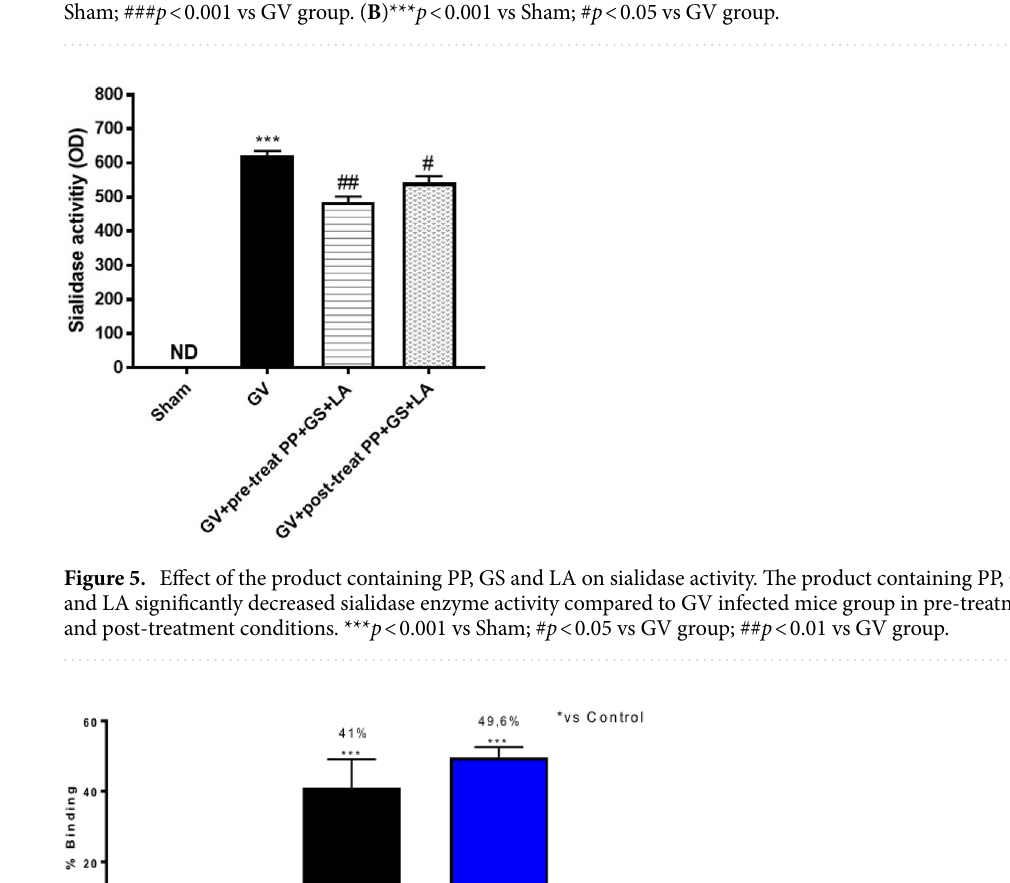
Figure 4. Effect of the product containing PP, GS and LA on MPO activity. The product containing PP, GS and LA significantly decreased MPO activity in pre-treatment condition compared to GV group ( A ). Moreover, the product containing PP, GS and LA was able to reduce MPO activity post GV infection ( B ). ( A ) *** p < 0.001 vs Sham; ### p < 0.001 vs GV group. ( B )*** p < 0.001 vs Sham; # p < 0.05 vs GV group.